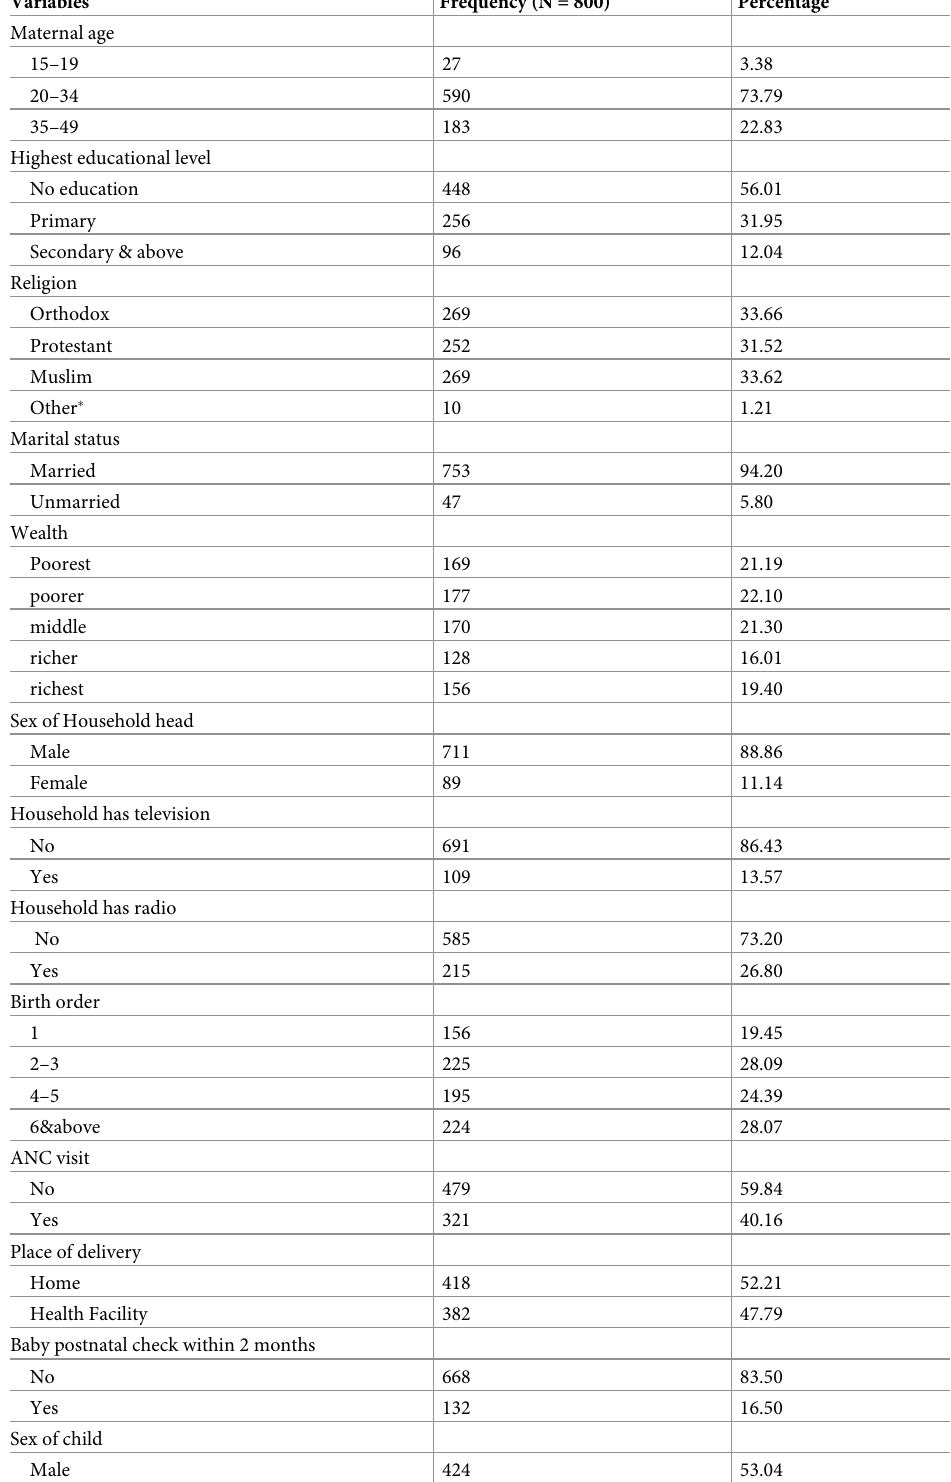
Table 1. Characteristics of study